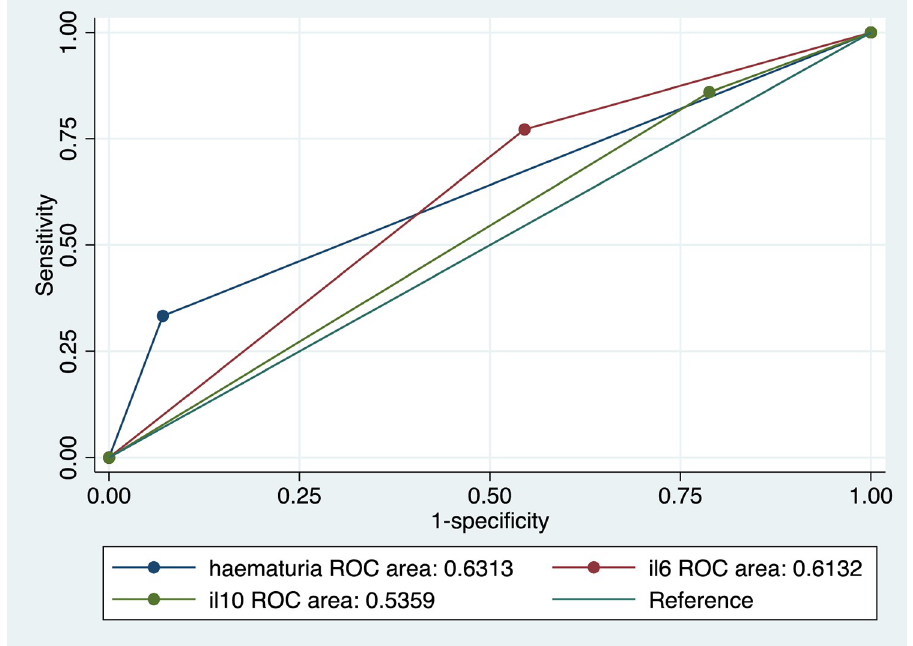
Fig 2. ROC curve showing the areas under the curve for IL-6, IL-10 and haematuria using urine microscopy as the reference for the diagnosis of infection with S . haematobium . il6 = IL-6, il10 = IL-10.